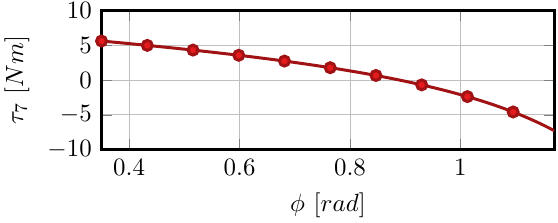
Figure 8. Output torque τ 7 over the selected configuration range.